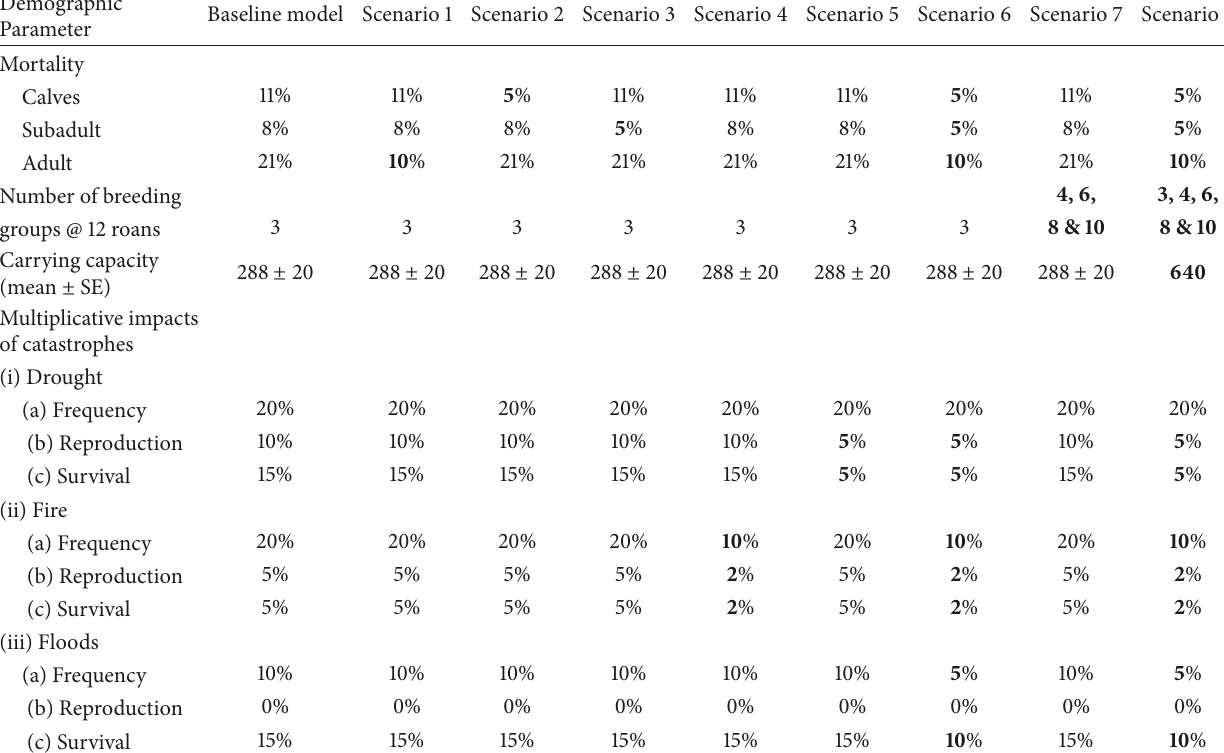
Table 2: Demographic parameters of roans used by different PVA scenarios in comparison with the baseline model. All other parameters are the same as those listed in Table 1. The scenarios/management options are (1) reducing adult mortality; (2) reducing calf mortality; (3) reducing subadult mortality; (4) reducing effects of fire; (5) reducing effects of drought; (6) combined interventions; (7) restocking with current scenario; (8) protected sanctuary together with restocking. The values in bold are those different from the baseline